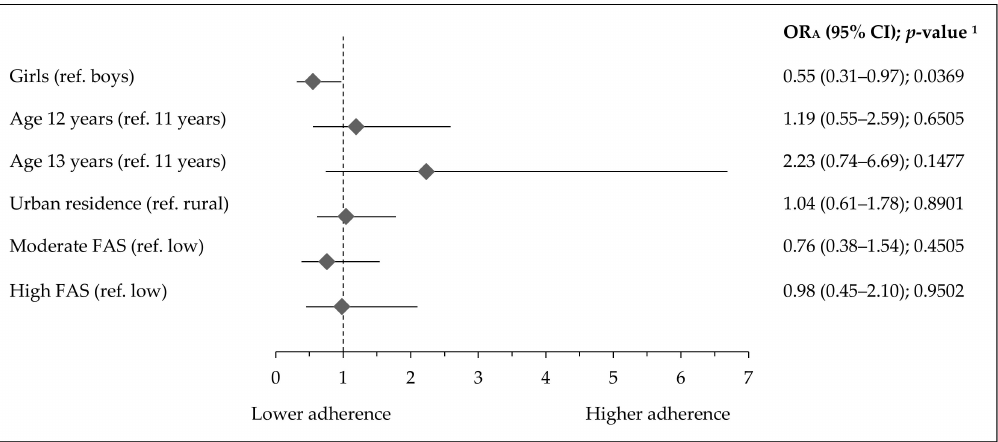
Figure 7. Factors associated with highST-highPA pattern in Polish teenagers (ref. lowST-highPA pattern). Notes: ST—screen time; PA—physical activity; FAS—Family A ffl uence Scale; OR A —odds ratio adjusted for gender, age (years), residence (categorical variable), FAS (points) and Nutrition Knowledge Score (points) excluding the modelled variable from confounders set, respectively; 95% CI—confidence interval; 1 Wald test significance